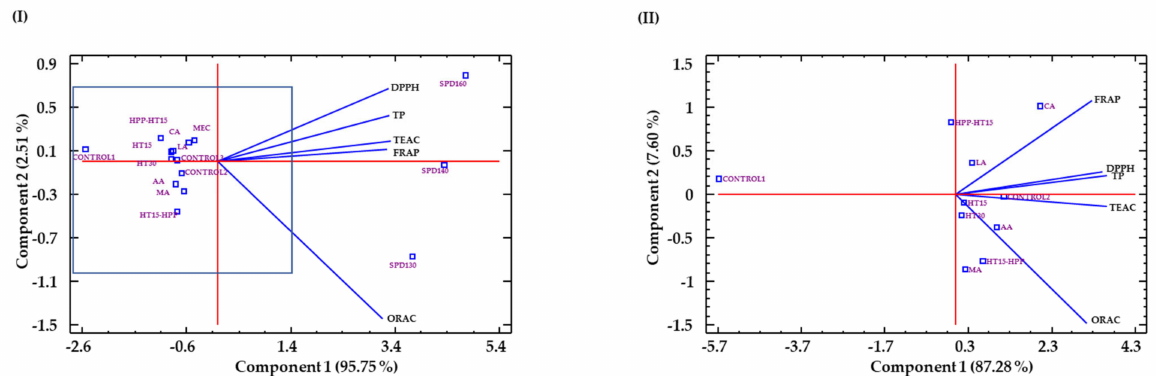
Figure 7. Biplots of ( I ) PCA analysis of antioxidant results of hydrolyzed WB and ( II ) PCA analysis of the samples within the inner rectangle, i.e., excluding SPD samples. Sample identification: hydrolyzed WB without hydrothermal treatment (CONTROL), with hydrothermal treatment for 15 min (HT15), with hydrothermal treatment for 30 min (HT30), with hydrothermal treatment for 15 min and HHP (HT15-HHP), with HHP and hydrothermal treatment for 15 min (HHP- HT15), treated with citric acid (CA), malic acid (MA), acetic acid (AC), lactic acid (LA), spray-dried at 130 ◦ C (SPD130), 140 ◦ C (SPD140), 160 ◦ C (SPD160), and microencapsulated with Pisane C 9 at 130 ◦ C (MEC). Abbreviations: 2,2 (cid:48) -azino-bis (3-ethylbenzothiazoline-6-sulfonic acid) (ABTS); 2,2-diphenyl-1-picryl-hydrazyl-hydrate (DPPH); ferric reducing antioxidant power (FRAP); oxygen radical absorbance capacity (ORAC); total phenolics